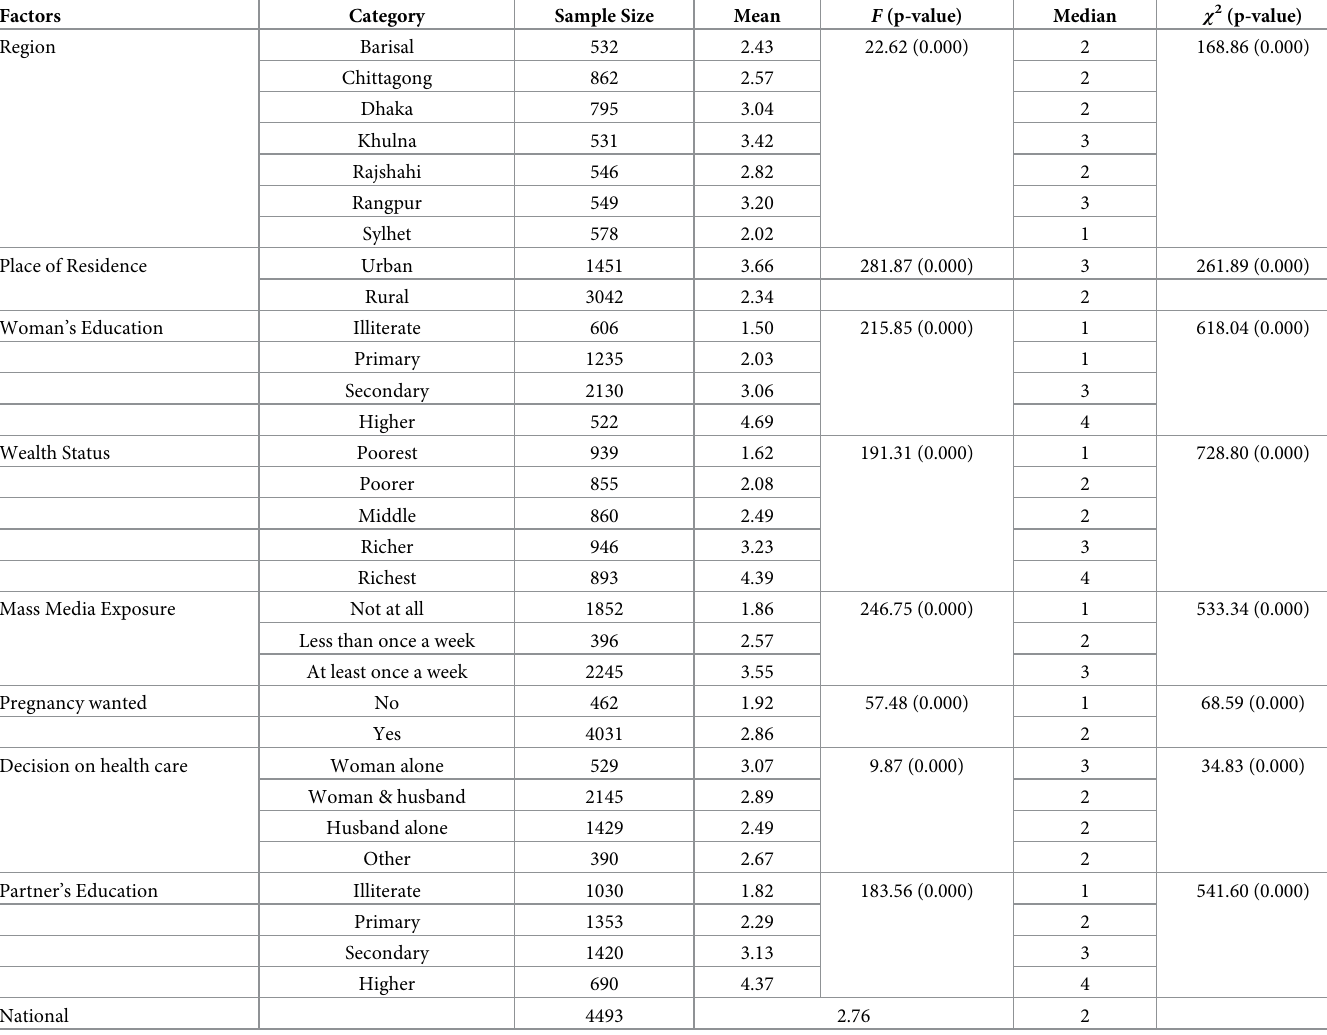
Table 1. Mean and median number of antenatal care (ANC) visits in Bangladesh according to women’s background characteristics, and the associated statistical F- test and Chi-Square ( χ 2 ) test for equality of the means and medians, respectively. Factors